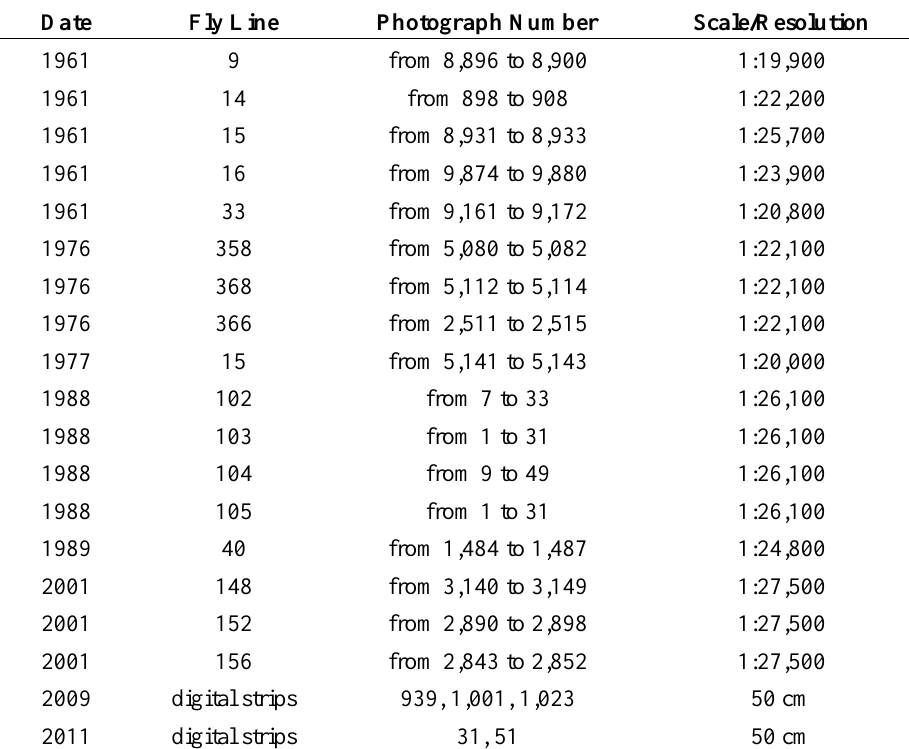
Table 1. Aerial photographs